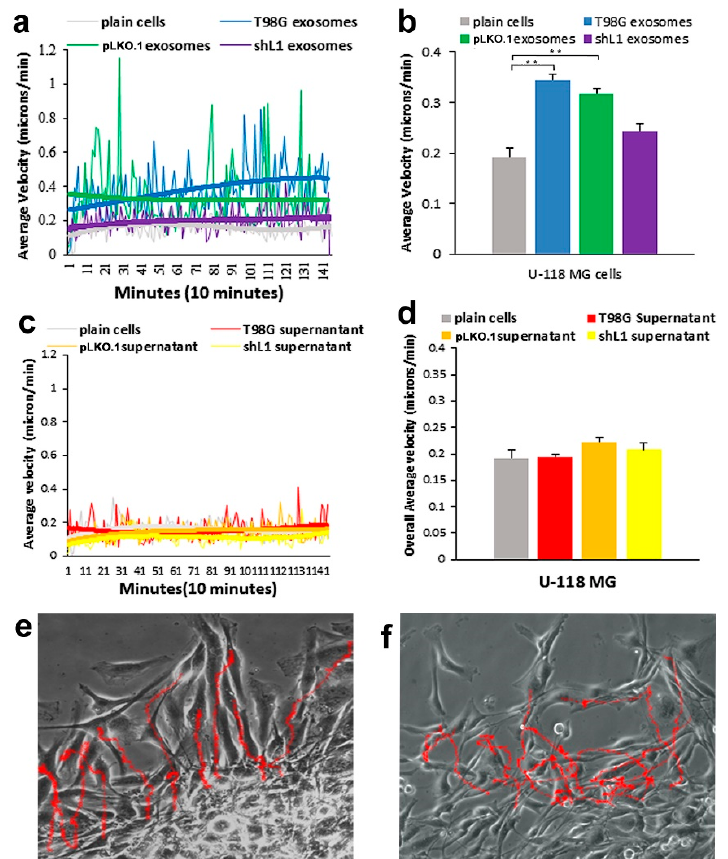
Figure 2. Motility of U-118 MG cells after exosome and supernatant fraction treatment. ( a ) Average velocity of cells tracked over time with exosome fractions added. The trend lines (thick lines) for T98G and pLKO.1 exosome types were distinctly above those of the plain cells and shL1 exosomes. ( b ) Overall average velocity of cells with exosome treatments. ( c ) Average velocity of cells tracked over time with supernatant fractions added. ( d ) Overall average velocity of cells with supernatant treatments. There was no significance difference in these motility rates with ANOVA analysis. ( e ) and ( f ) Cell track images of cells with T98G exosomes and T98G supernatant fractions, respectively. ** p < 0.001.